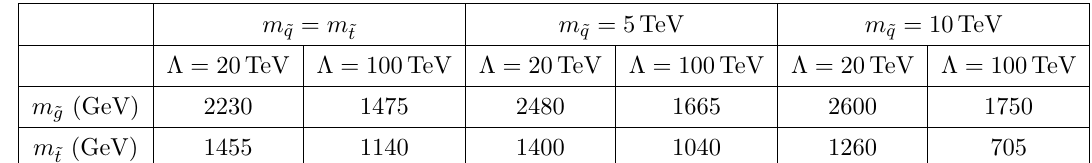
Table 1 . Upper limits on the mass of the gluino m ~ g and stop squark m ~